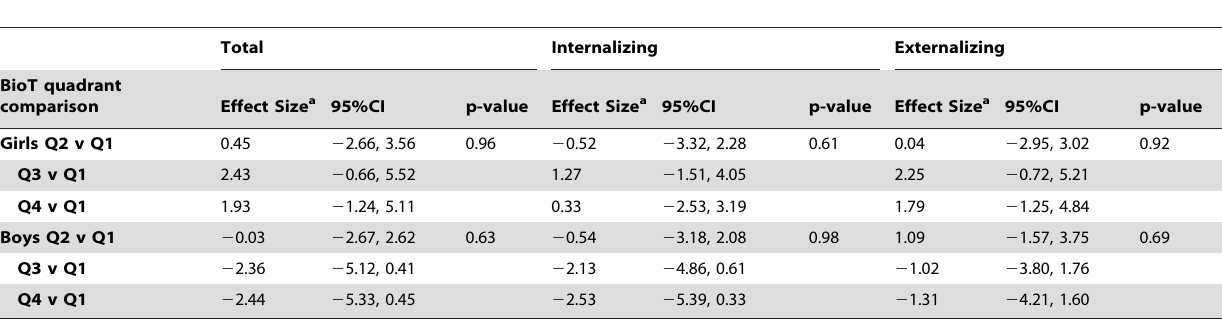
Table 3. Random effects model effect of prenatal bioavailable testosterone (BioT) levels on CBCL T-scores at age 5–10 years.